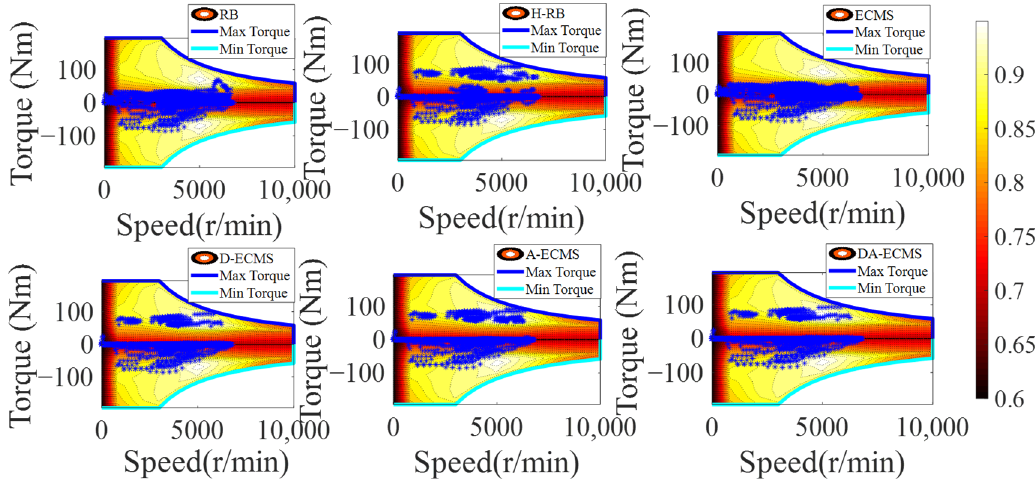
Figure 18. Rear motor operating points of energy management strategies.